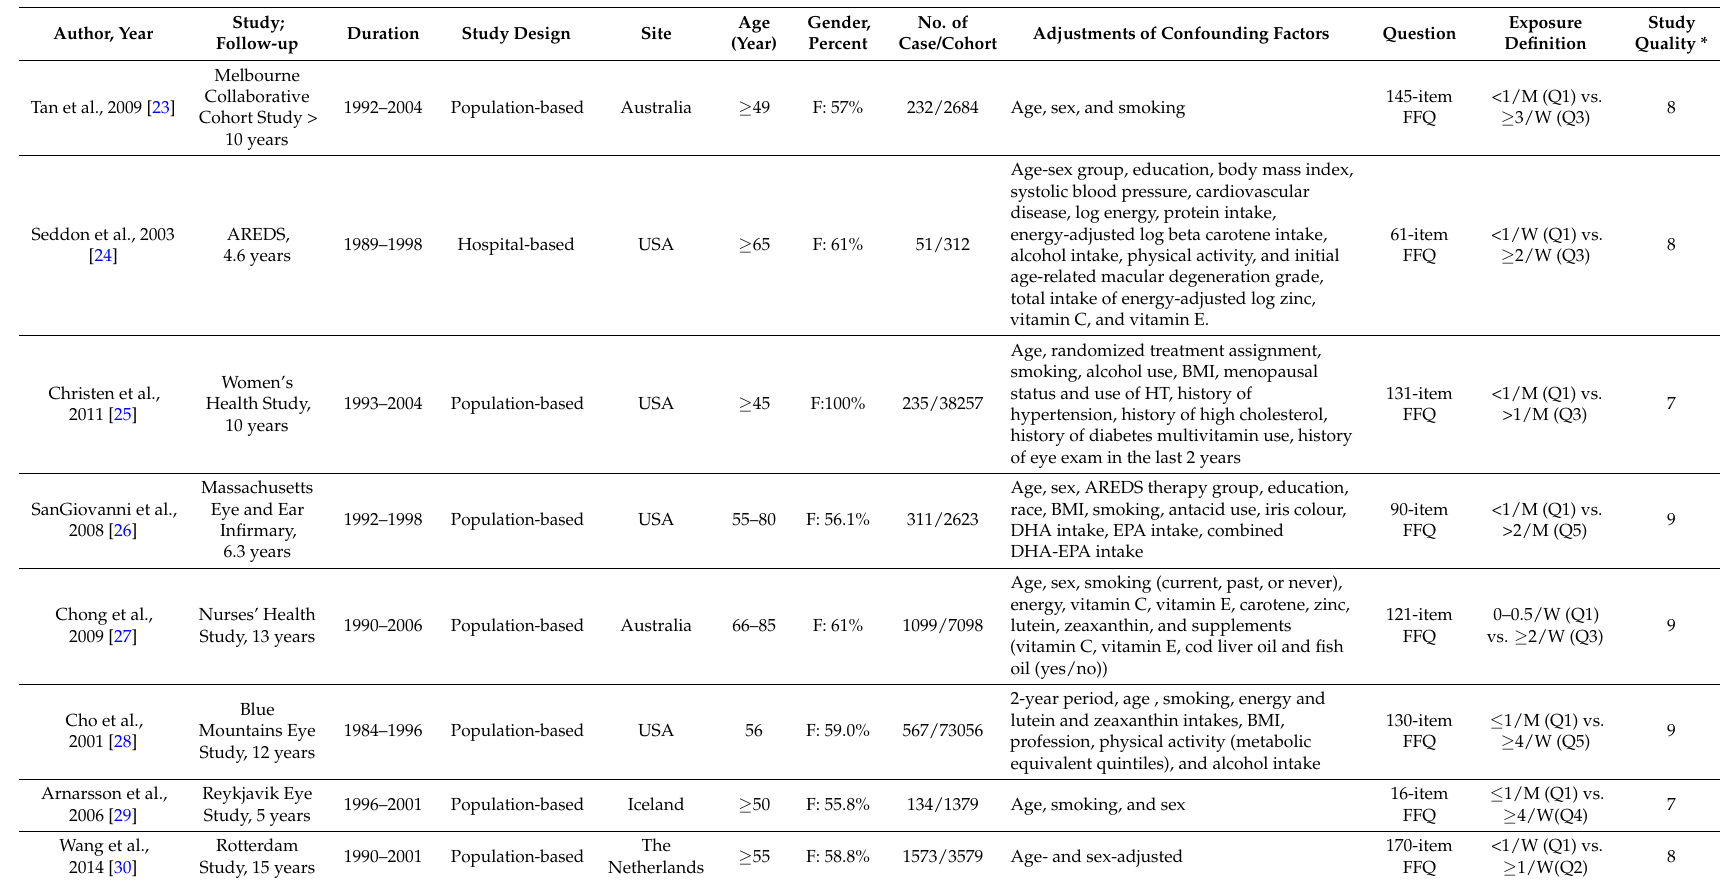
Table 1. Characteristics of eligible